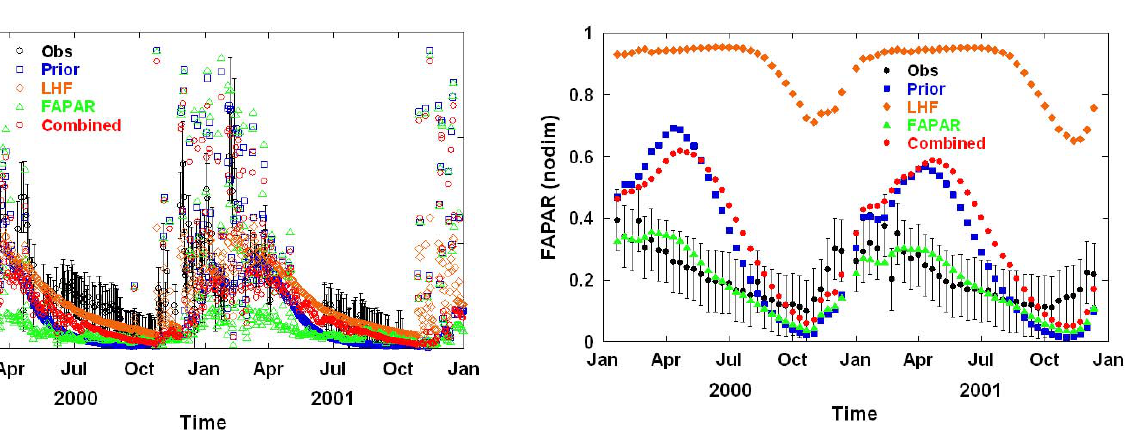
Fig. 4. Observed and simulated fraction of absorbed photosyntheti- cally active radiation (FAPAR) for the years 2000–2001, at 10-day intervals. Observed FAPAR is derived from the SeaWiFS instrument of the National Aeronautics and Space Administration (NASA). The error bar of observed FAPAR (Obs) represent the data un- certainty used in CCDAS. “Prior” is the unconstrained simulation; “LHF”, “FAPAR” and “Combined” denote which data streams were used when assimilating. Root mean square errors (RMSEs) of simu- lated FAPAR against observations are 0.195, 0.675, 0.056 and 0.202 for Prior, LHF, FAPAR and Combined, respectively.